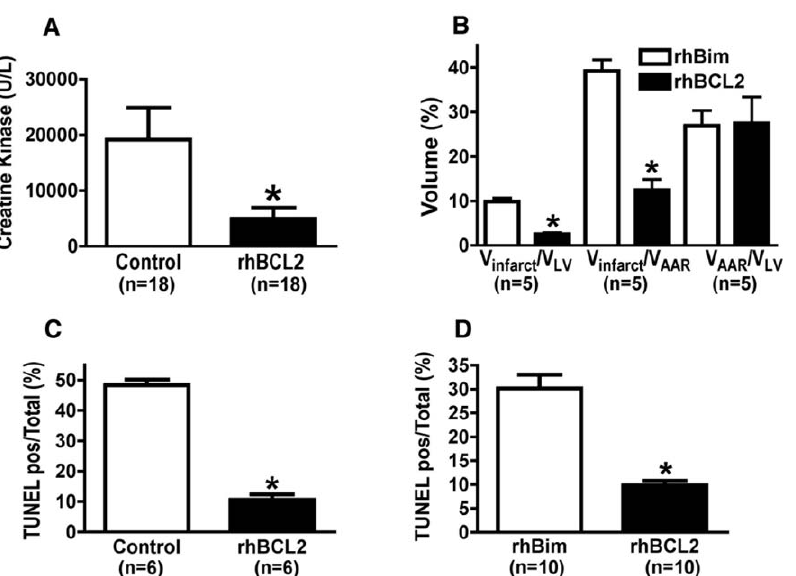
Figure 1. rhBCL2 protects hind limb skeletal muscle and cardiac muscle from I/R injury and apoptosis. (A) Creatine kinase (CK) levels in plasma were determined in mice treated ip with rhBCL2 protein (1 m g/mouse) or rhUbiquitin (0.5 m g/mouse) or vehicle solution the day prior to the hind limb I/R. Ischemia was produced by cross-clamping of the aorta for 90 min followed by 3 hrs of reperfusion. There were no differences in plasma CK levels between the rhUbiquitin-treated and vehicle-treated mice, and results from these treatments were combined. Muscle injury following I/R was significantly reduced by pretreatment with rhBCL2 ( *p , 0.05 rhBCL2 vs. control). (B) Mice were subjected to 60 minutes of LAD coronary artery occlusion and 2 hours of reperfusion and then evaluated for infarct size. Volume of area at risk (VAAR), left ventricle volume (VLV), and infarct volume (Vinfarct) were determined in mice pretreated the day prior to cardiac I/R with rhBCL2 (1 m g/mouse ip) or rhBim (1 m g/mouse ip). Treatment with rhBCL2 significantly reduced Vinfarct compared to treatment with rhBim (* p , 0.001). (C) The number of TUNEL-positive nuclei in skeletal muscle of the rhBCL2-pretreated mice, expressed as a percent of the total number of nuclei, was reduced compared with control mice (*p , 0.001). (D) The number of TUNEL-positive nuclei in cardiomyocytes, expressed as a percent of the total number of nuclei, was reduced in rhBCL2-pretreated mice compared with rhBim-pretreated mice (*p , 0.001).